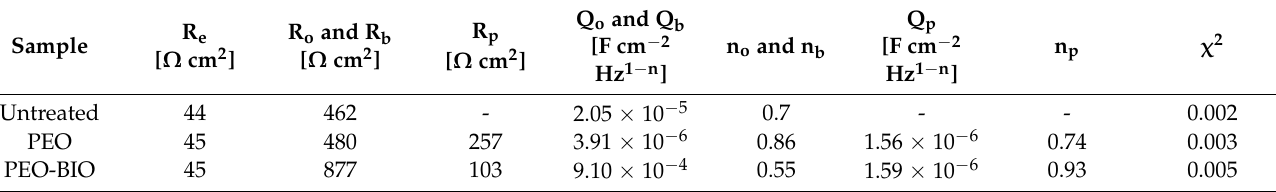
Figure 6. Equivalent circuits employed to fit the electrochemical impedance spectroscopy (EIS) experimental data coming from the untreated sample ( a ) and the PEO and PEO-BIO samples ( b ) and Nyquist plot coming from EIS tests performed on the different samples ( c ). Dots represent experimental data and lines are the results of the fitting. Test electrolyte: simulated body fluid at 37 °C. Table 3. Results of the fitting of the experimental data coming from EIS